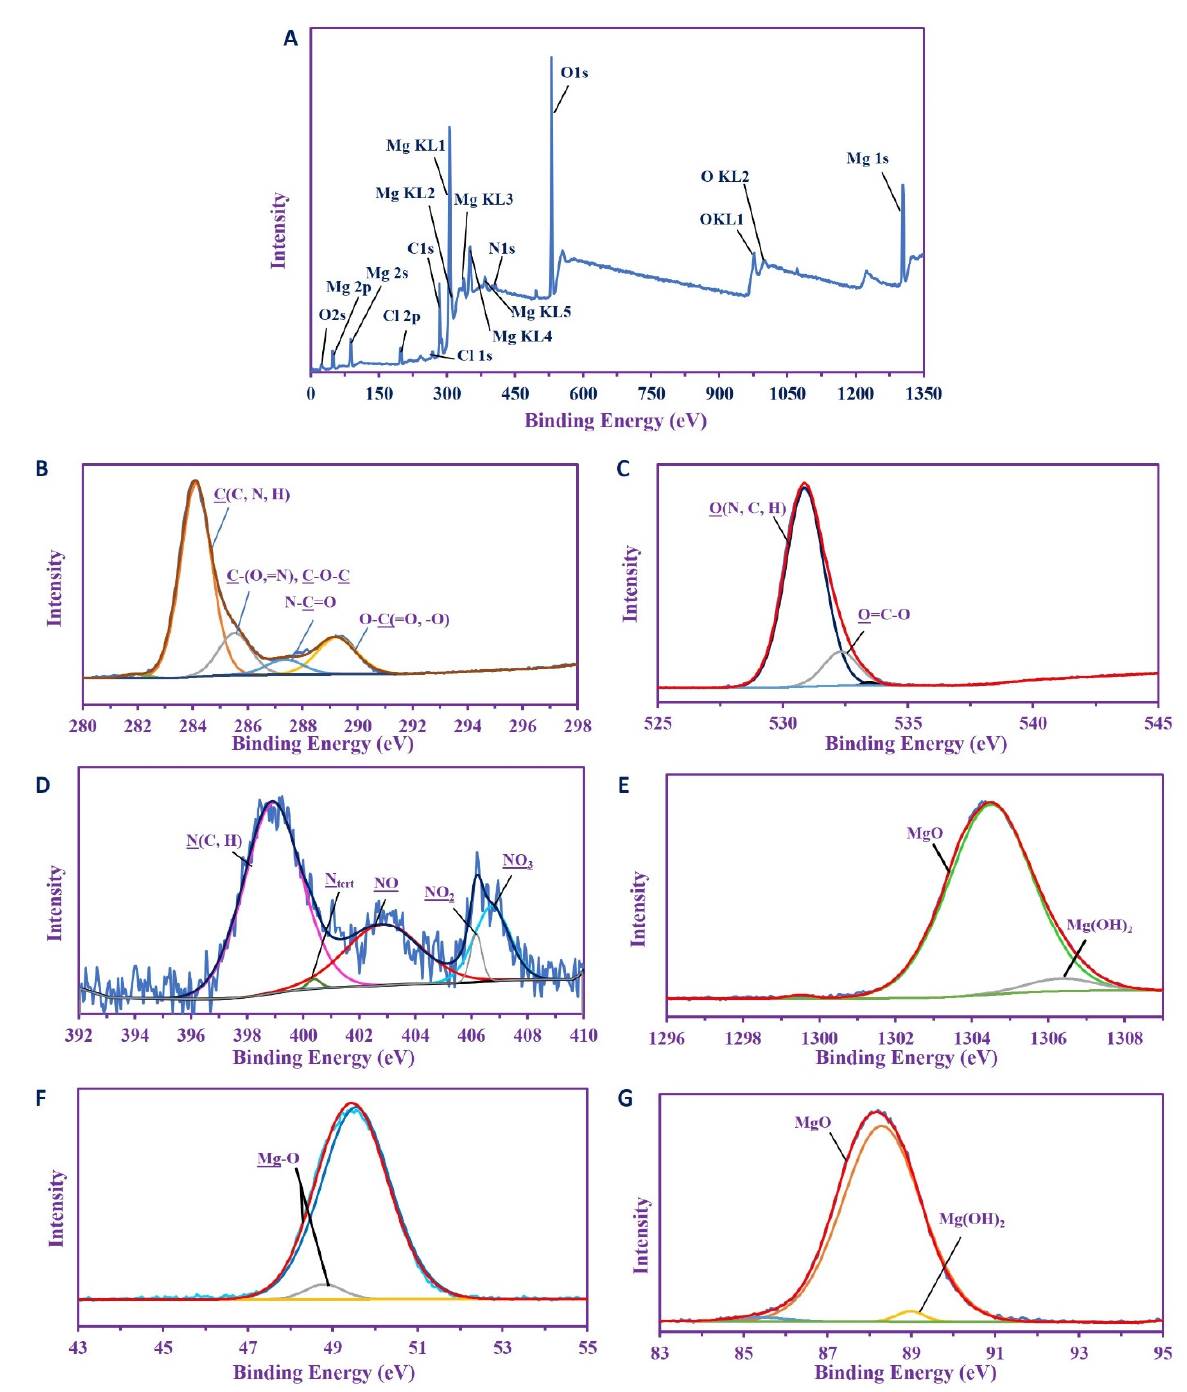
Figure 4. XPS analysis of biosynthesized MgO-NPs. ( A ) Overall survey, ( B ) C 1s, ( C ) O 1s, ( D ) N 1s, ( E , F , and G ) Mg 1s, Mg 2p, and Mg 2s, respectively.